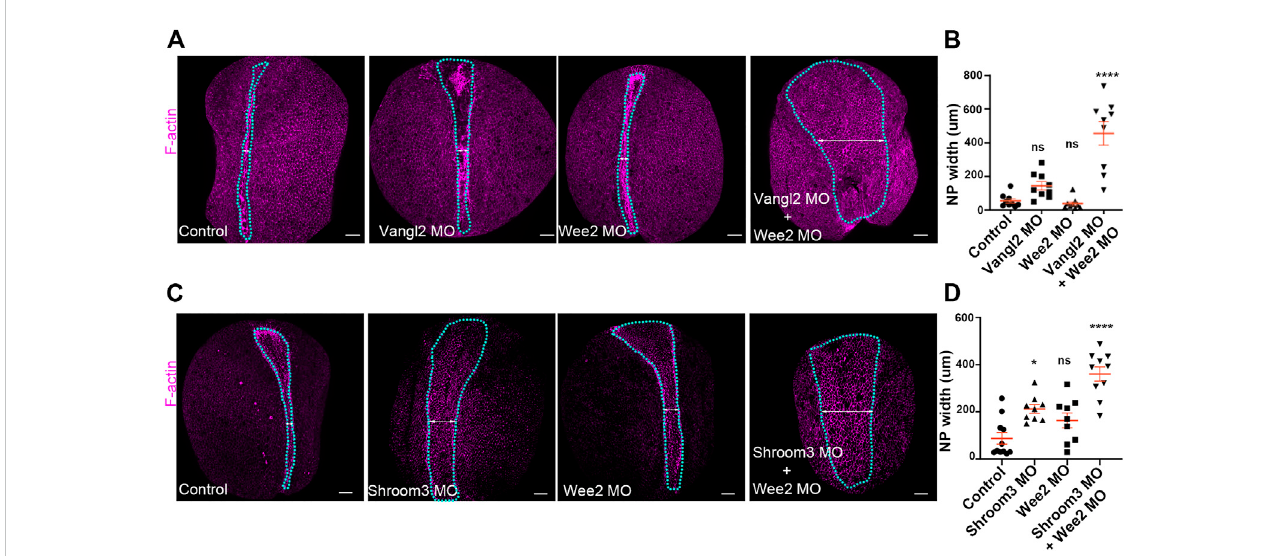
FIGURE 7 Defects in neural plate and somitic mesoderm morphogenesis have additive impact on neural tube closure. (A) Dorsal views of representative Control, Vangl2 morphant, Wee2 morphant and Vangl2/Wee2 double morphant embryos. Blue outline: neural plate. Double headed arrow: neural plate width. Scale bars: 100 μ m. Control and morphant embryos are siblings raised side by side (B) Quanti fi cation of neural plate width in Control, Vangl2 morphant, Wee2 and Vangl2/Wee2 double morphant embryos. Neural tube closure is severely affected in Vangl2/Wee2 double morphant embryos. One-way Anova; ns: no signi fi cant; **** p < .0001; mean ± SEM n = 9 embryos. (C) Dorsal views of representative Control, Shroom3 morphant, Wee2 morphant and Shroom3/ Wee2doublemorphantembryos.Blueoutline:neuralplate.Doubleheadedarrow:neuralplatewidth.Scalebars:100 μ m.Controlandmorphantembryosare siblings raised side by side (D) Quanti fi cation of neural plate width in Control, Shroom3 morphant, Wee2 morphant and Shroom3/Wee2 double morphant embryos. Neuraltube closure is severely affected in Shroom3/Wee2 double morphantembryos. One-way Anova; ns: no signi fi cant; * p = .106: **** p < .0001; mean ± SEM n = 11 control, 9 Shroom3 and Wee2 morphant and 10 Wee2/Shroom3 double morphant